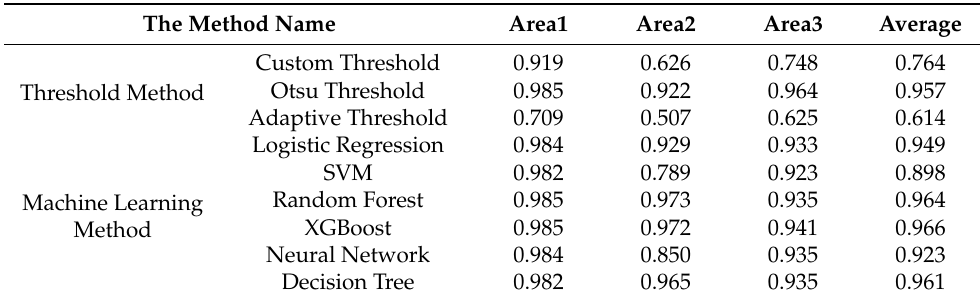
Table A1. Statistics of the AUC index of each algorithm applied in the three regions.